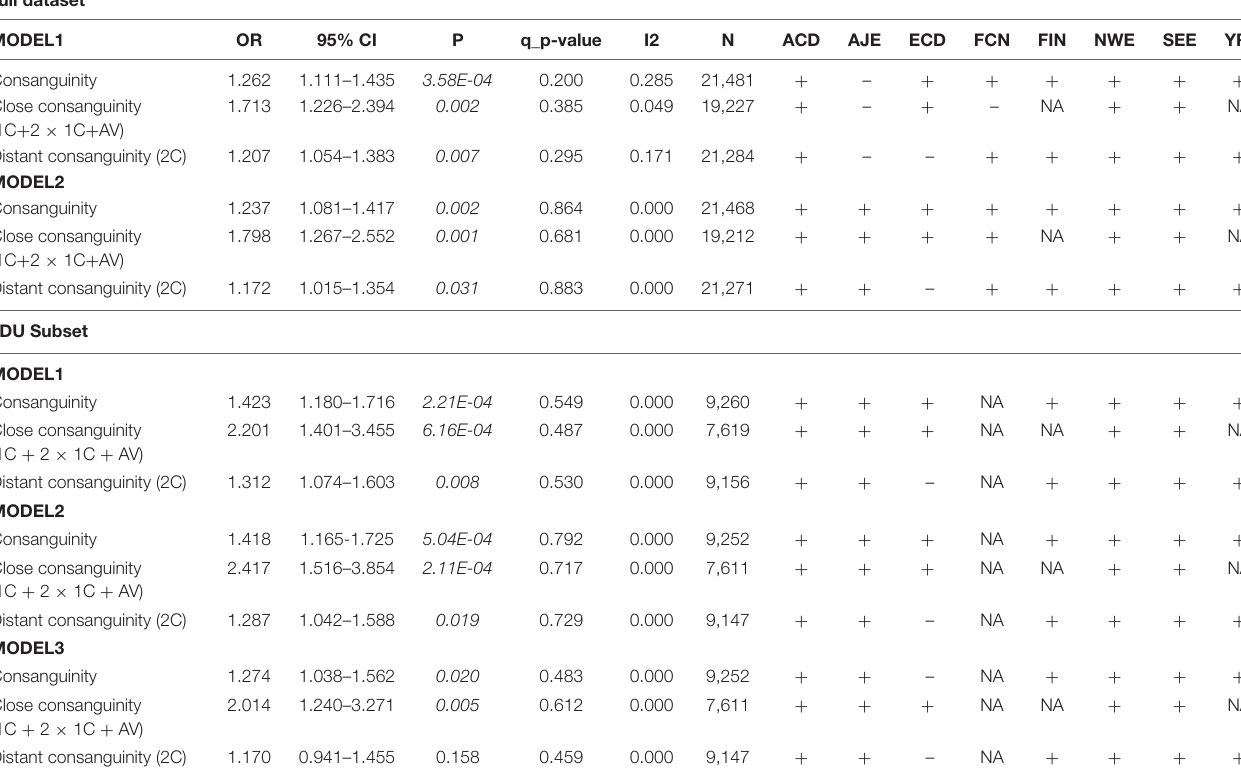
TABLE 3 | Consanguinity increases the risk of